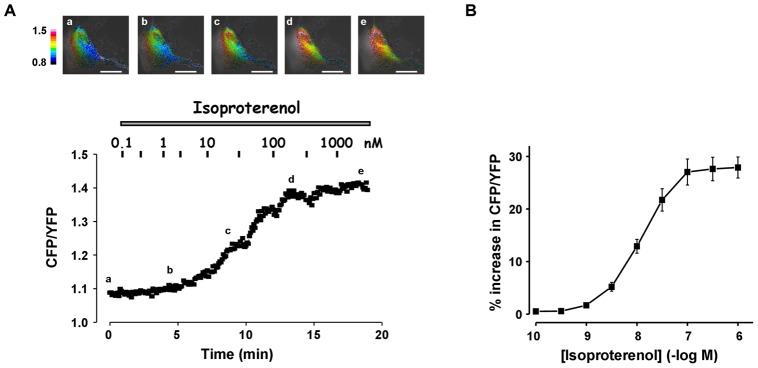
Effect of steady-state activation of β-AR on cytosolic [cAMP] in RASMCs.Cytosolic cAMP measurements were conducted using the FRET-based cAMP sensor Epac1-camps in cultured RAMSCs cells incubated with cumulative increasing concentrations of isoproterenol (0.1 nM to 1 µM). A: Representative cAMP signals monitored in one cell. Pseudocolor images reflecting the CFP/YFP ratio were recorded at the times indicated by the letters on the graph. B: Concentration-response curve of isoproterenol effect as shown in A. Data are mean±SEM of 7 independent cells.